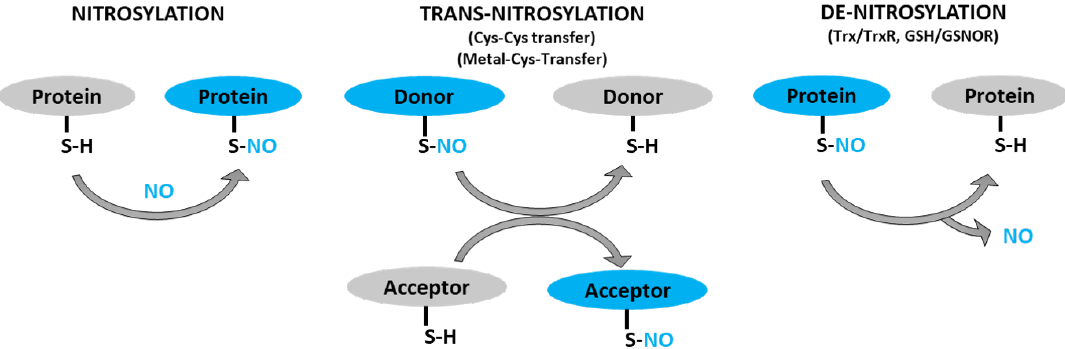
Figure 1. Schematic representation of protein S-nitrosylation, transnitrosylation, and denitrosylation. S-nitrosylation : covalent addition of NO group to the thiol (SH) group of a cysteine residue to form S-nitrosothiol (SNO). Trans-nitrosylation : transfer of NO moiety from donor to acceptor protein. Denitrosylation : removal of NO group from an already S-nitrosylated protein by denitrosylase (Trx/TrxR, GSNO/GSNOR) .